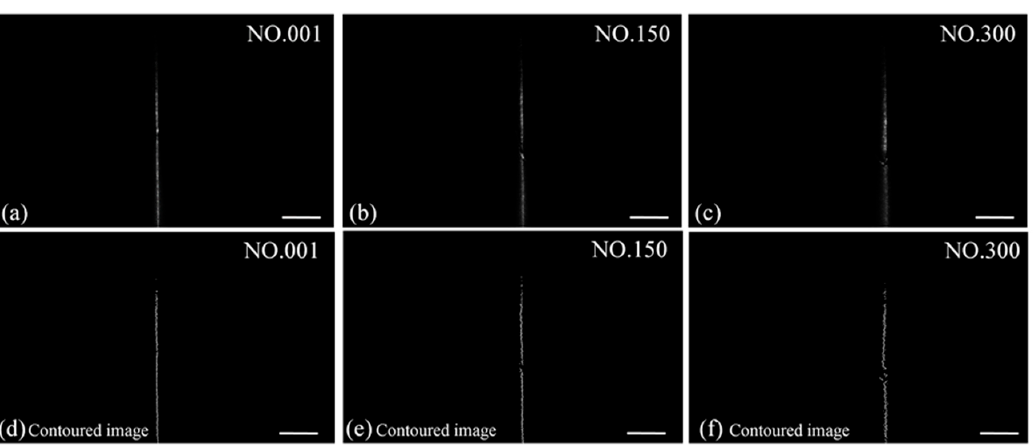
Figure 3. Captured images of the light-sheet during z-direction offset calibration. Images from the 1st, 150th and 300th steps are shown in ( a – c ). After contour extraction, the contoured images are shown in ( d – f ). Scale bar: 1 mm.